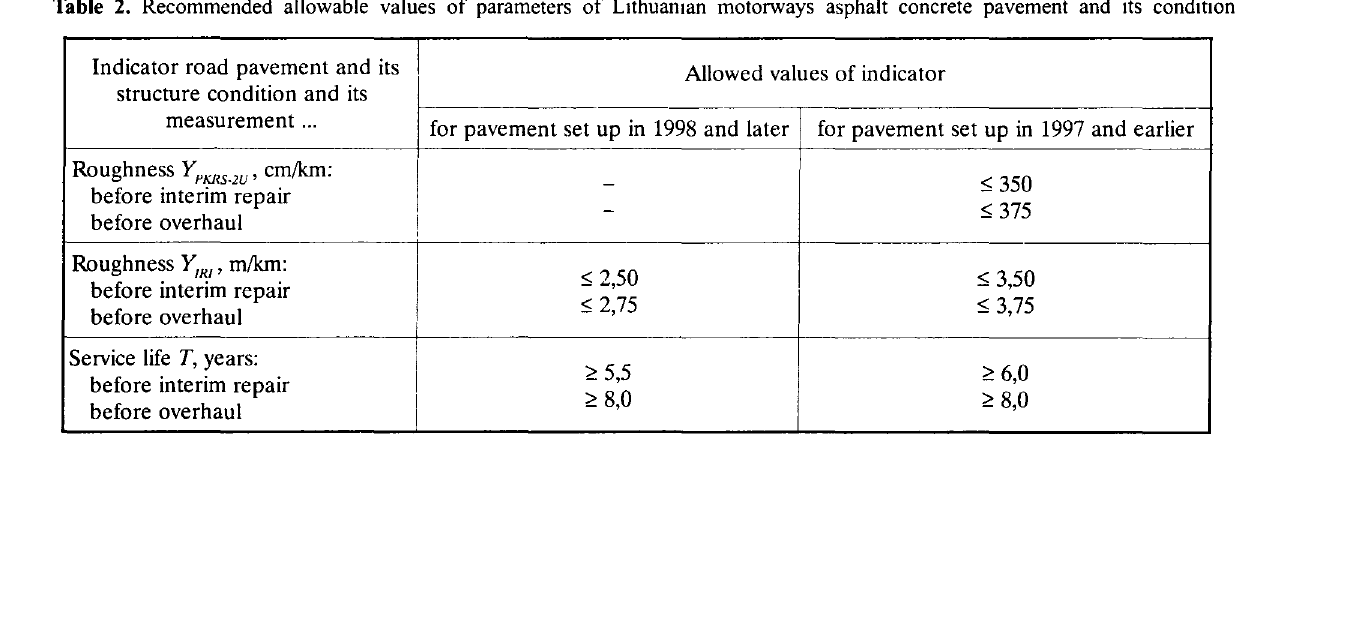
Table 2. Recommended allowable values of parameters of Lithuanian motorways asphalt concrete pavement and its condition Indicator road pavement and its Allowed values of indicator structure condition and its measurement